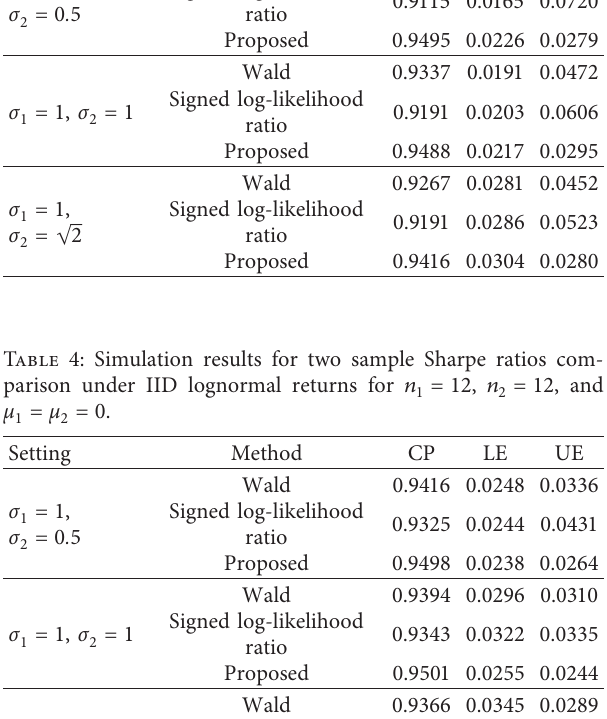
Table 3: Simulation results for two sample Sharpe ratios com- parison under IID lognormal returns for n Setting LE � 1, σ 1